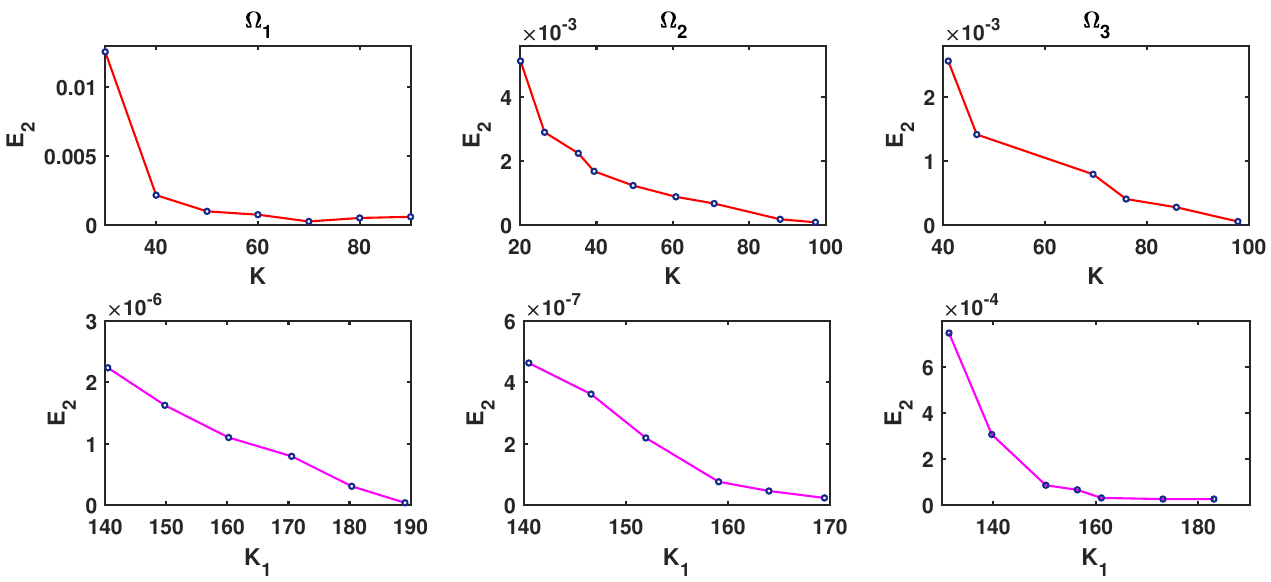
Figure 9. E 2 –errors and convergence for Example 3 in different domains at T = 0.5, where τ = 0.04, c = 5, ν = 2, σ = 2.6, γ = 0.5, M = 209, N = 101, (red) K 1 = 40, and (pink) K = 140.